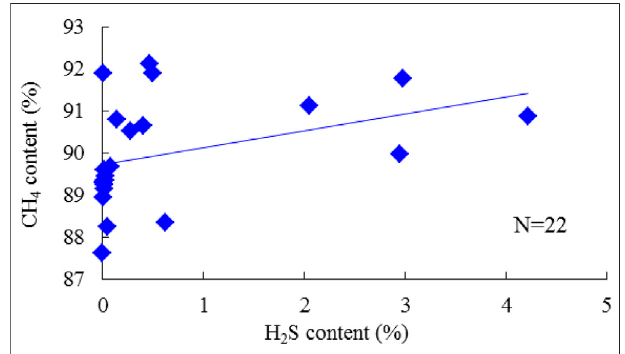
FIGURE 5 | Relationship between CH 4 and H 2 S